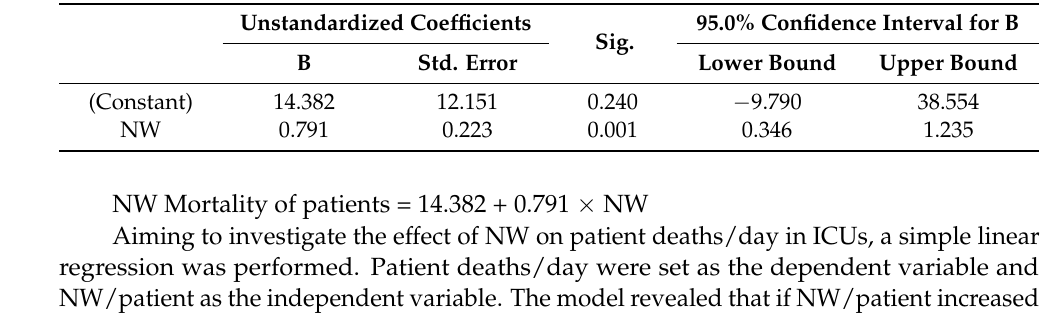
Table 9. NAS simple linear regression model and mortality.